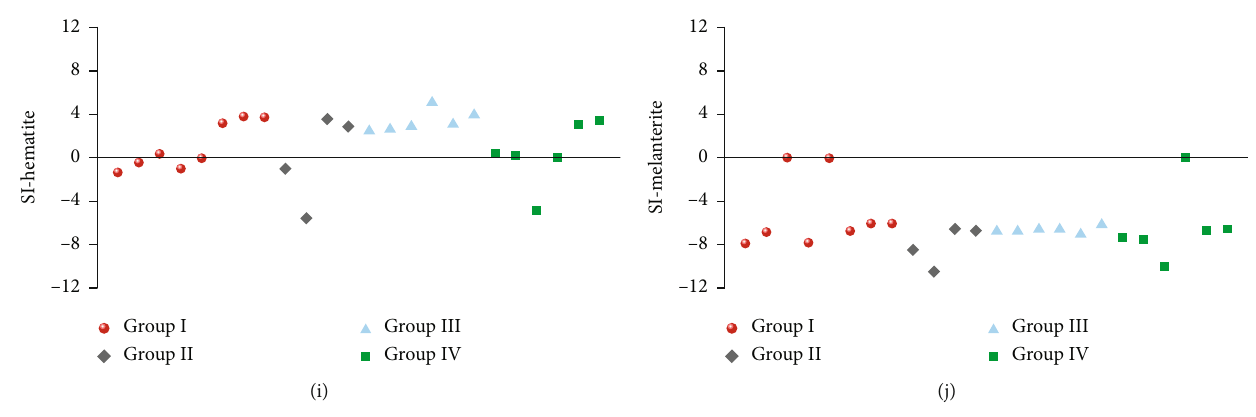
Figure 11: Saturation index of major minerals in the study area. Table 6: Water quality classi fi cation results based on water quality